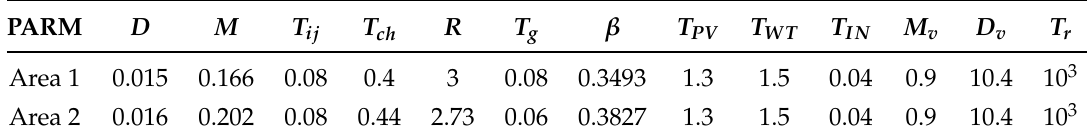
Table 2. The parameters of two-area power